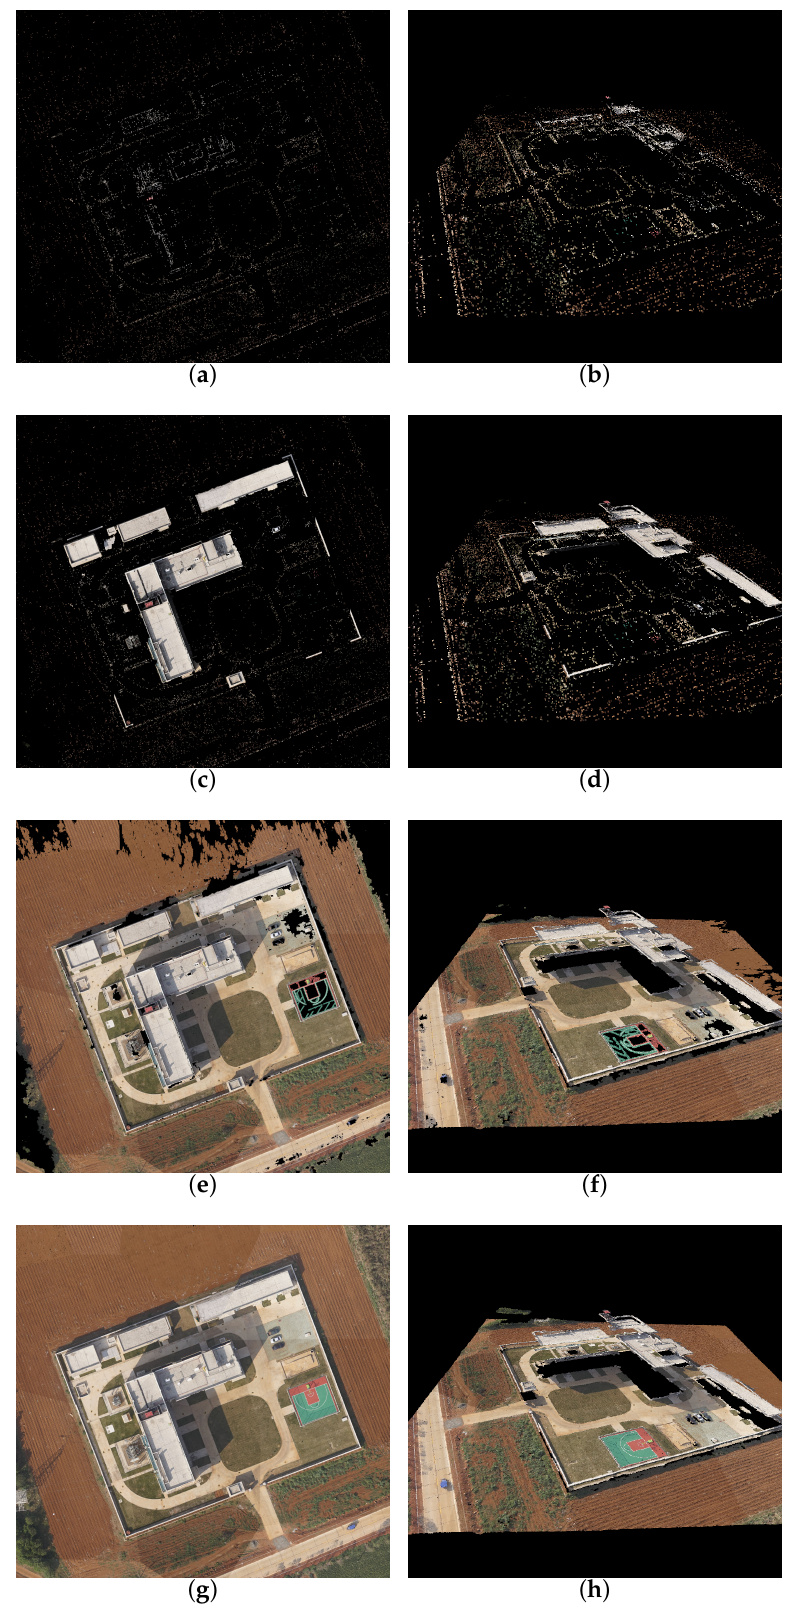
Figure 10. The beginning, two intermediate, and final results of the generation process. The left column ( a , c , e , g ) is the top view, and the right ( b , d , f , h ) is the corresponding oblique